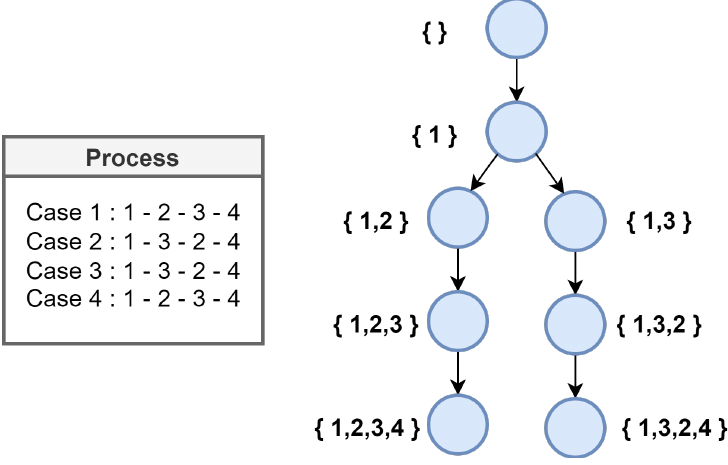
Figure 4. Petri net of event log.